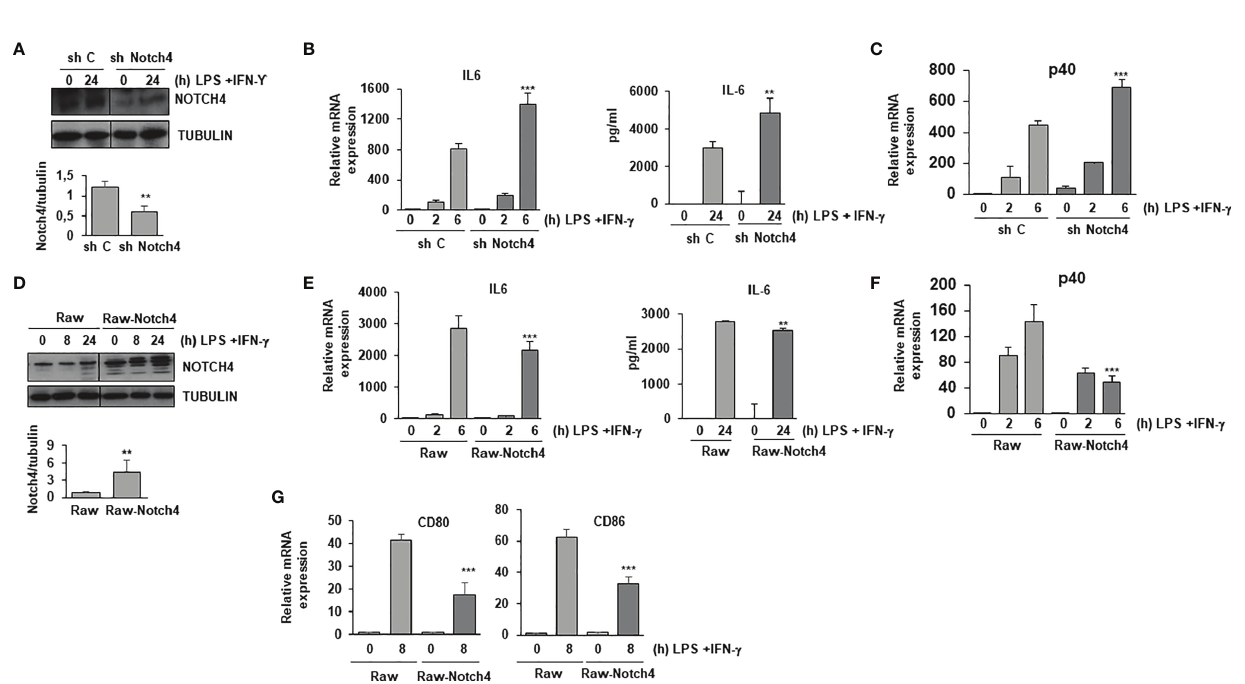
FIGURE 2 | NOTCH4 inhibits the expression of pro-in fl ammatory cytokines in TLR4 and IFN- g activated macrophages. (A) Western blot analysis of NOTCH4 expression in Raw 264.7 cells transiently transfected with control scrambled shRNA (sh C) or Notch4 shRNAs. One day after transfection, cells were stimulated